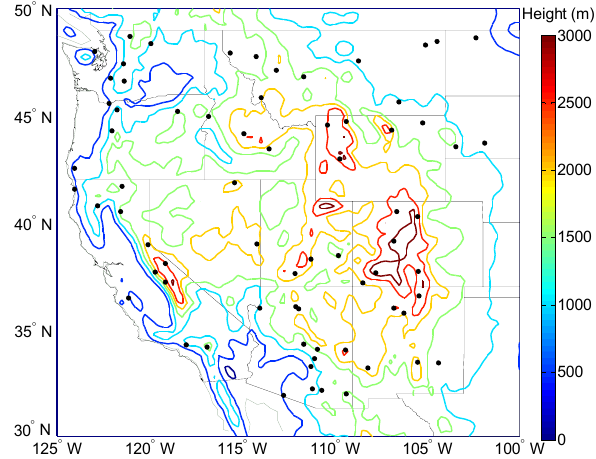
Fig. 1. IMPROVE sites (black dots; data available at http://vista. Figure 1 . IMPROVE sites (black dots; data available at cira.colostate.edu/improve/) in the Western US. Also shown are ter- http://vista.cira.colostate.edu/improve/) in the western U.S. Also shown are terrain rain heights (color heights (color contours).